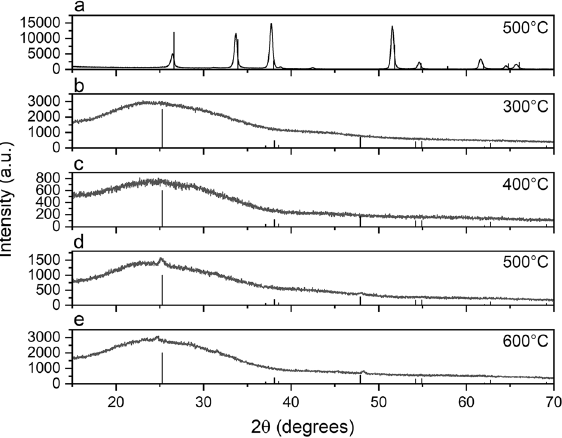
Figure 2. GIXRD patterns of TiO 2 thin films coated on the FTO side ( a ) and on the reversed non-FTO coated side of a quartz glass ( b – e ), respectively. Samples were calcined at the indicated temperatures. The diffraction pattern of the SnO 2 modification cassiterite ( a ) and the TiO 2 modification anatase ( b – e ), respectively, are displayed as vertical lines for